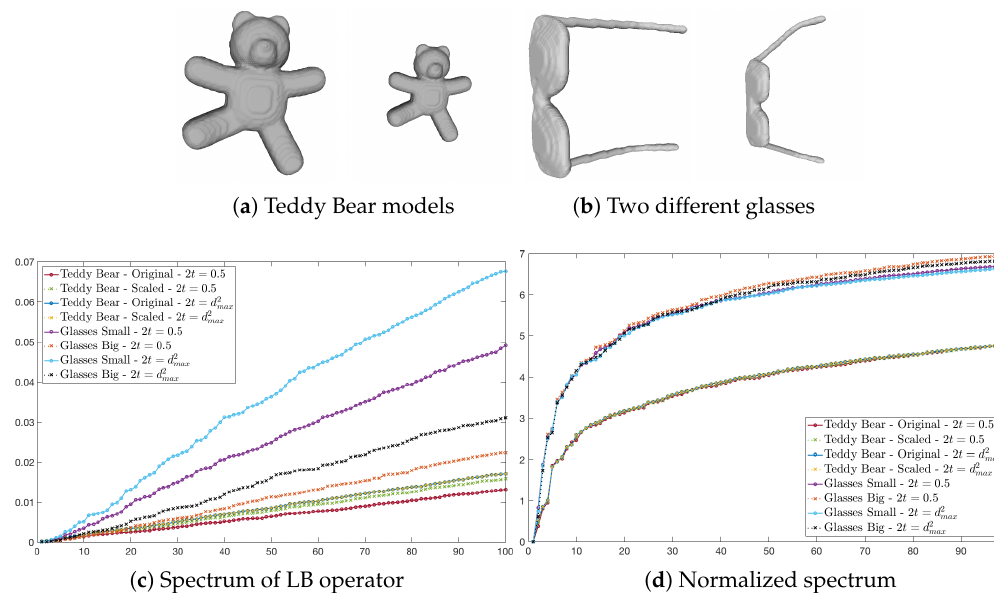
Figure 2. An example showing the proposed normalization method of the shape descriptor. ( a ) A Teddy Bear model and its scaled version (scale factor 0.7). ( b ) Two different glasses that vary in size. ( c ) The spectrum of the original Teddy Bear, scaled Teddy Bear, and both glasses with t = 0.5 and t = d 2 max . Please note that the spectrum of the original and scaled Teddy Bear models coincide when t = d 2 max . ( d ) The spectrum of all models after proposed